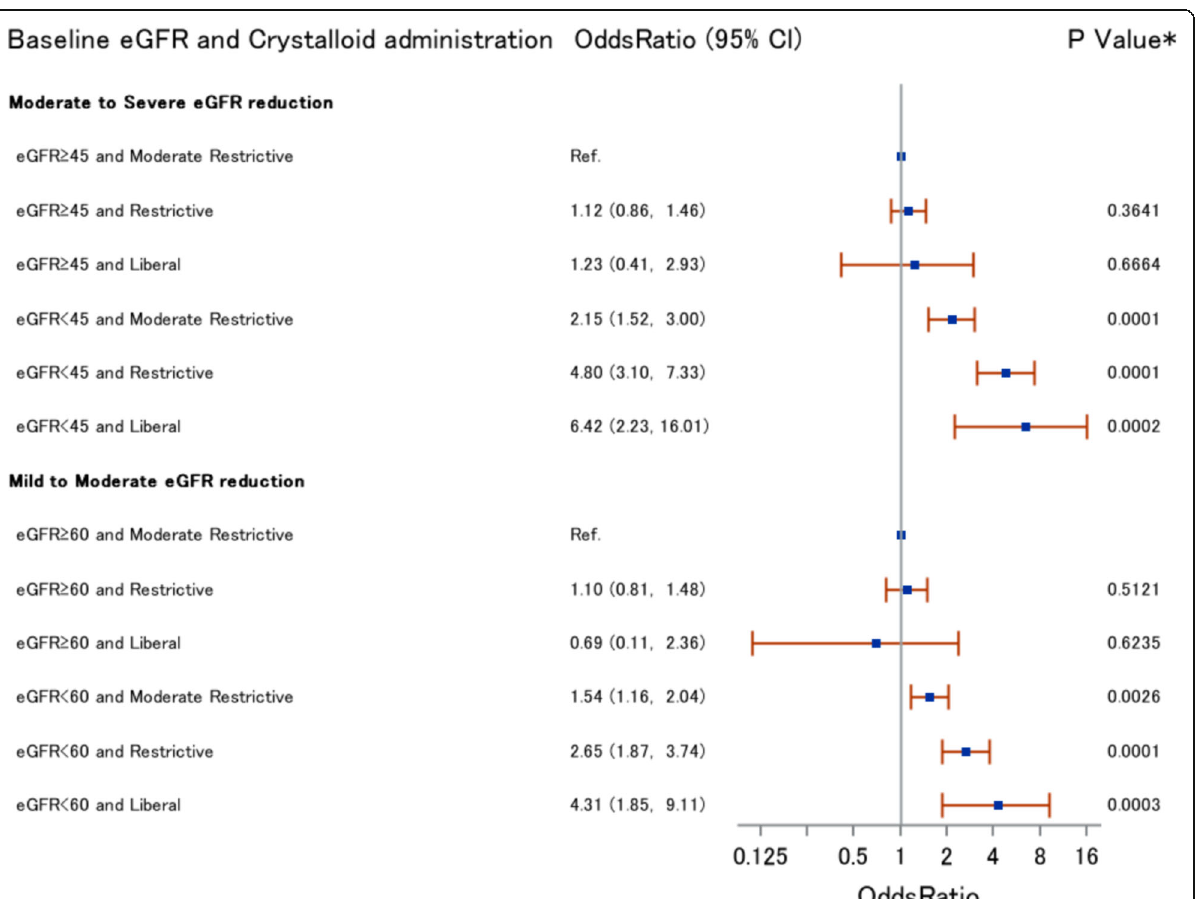
Fig. 2 Different effects of crystalloid administration based on baseline renal function level ( N =6296). “ Moderately restrictive ” refers to a